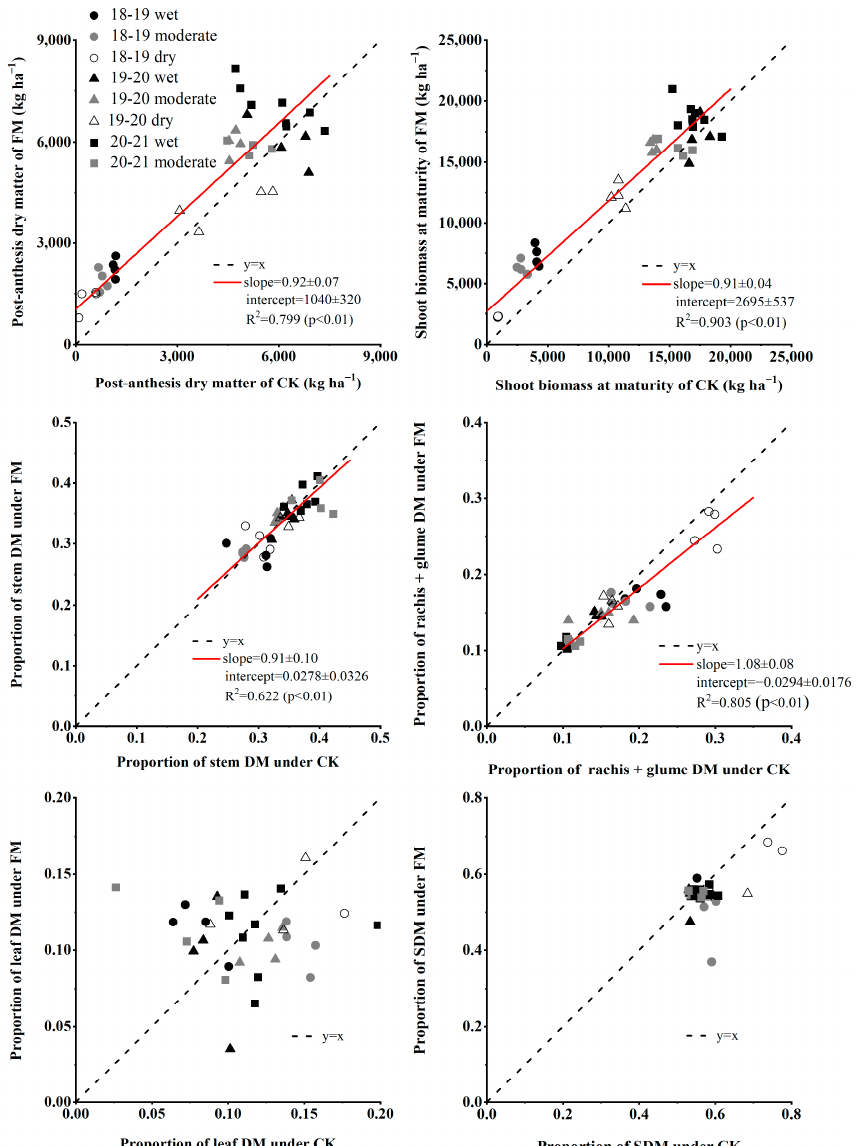
Figure 2. Comparison of post-anthesis dry matter, shoot biomass at maturity, and proportion of various organ’s dry matter (leaf DM, stem DM, ear DM, rachis and glume DM, structural DM) to above-ground dry matter (AGDM) at maturity between plastic film mulching (FM) and bare ground (CK) wheat crops. Data including all treatments and seasons. Red solid line and equation is Model II regression accounting for error in both x and y. Standard error of slope and intercept is presented. Grain yield varied from 234 to 8733 kg ha − 1 and was affected by initial soil water, mulch, and their interaction in 2018–2019 and 2019–2020 (Table 1). Mulch increased grain yield when compared to the control at all levels of initial soil water in 2018–2019, as well as at the moderate and dry treatments in 2019–2020. The Harvest index ranged from 2.26